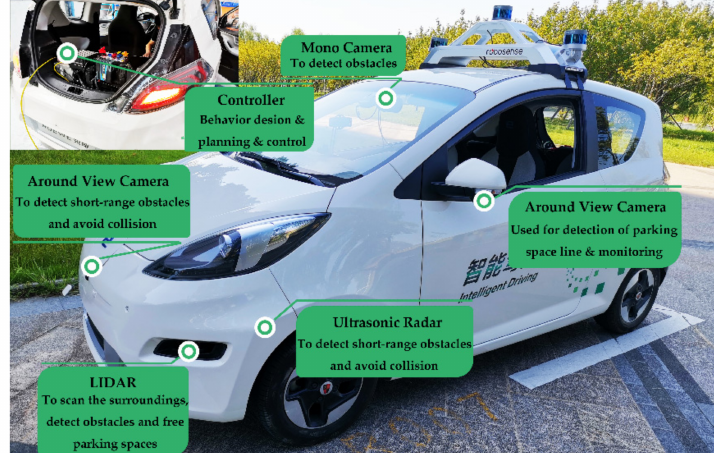
Figure 13. The test platform equipped with AVM, LiDAR and a 900 MHz